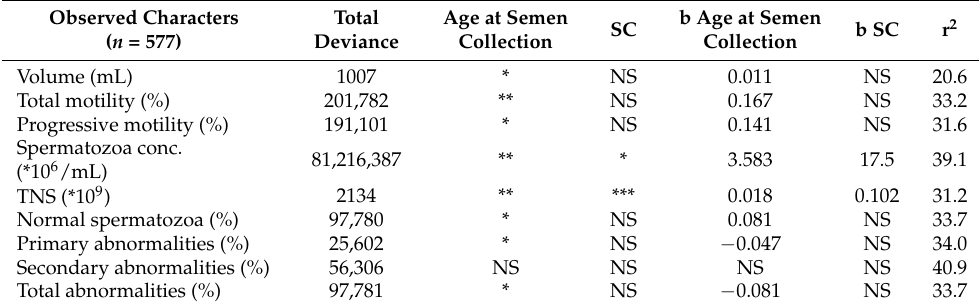
Table 3. Effect of the age at semen collection and scrotal circumference on seminal